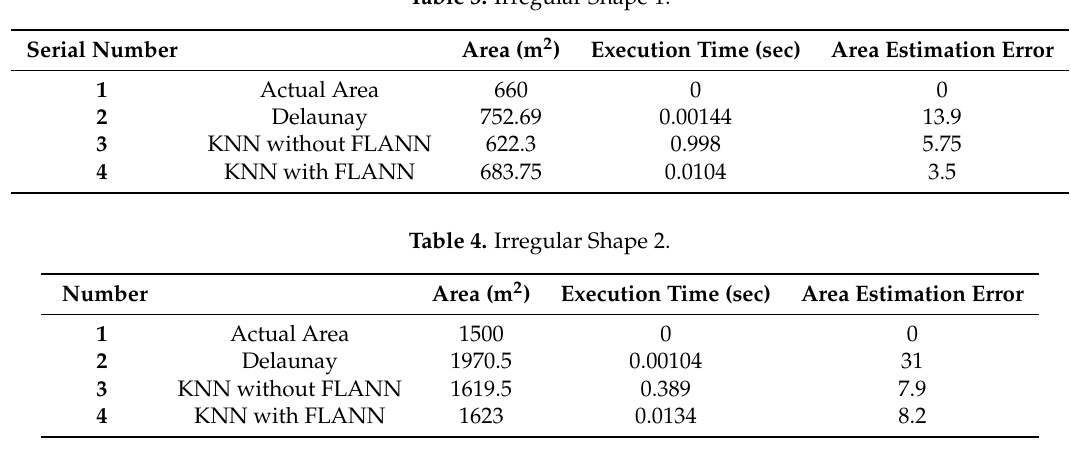
Table 3. Irregular Shape 1.